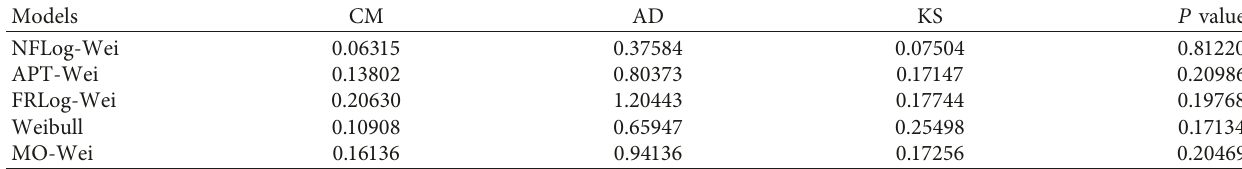
Table 8: The values of CM, AD, KS, and P value of the fitted models for Data